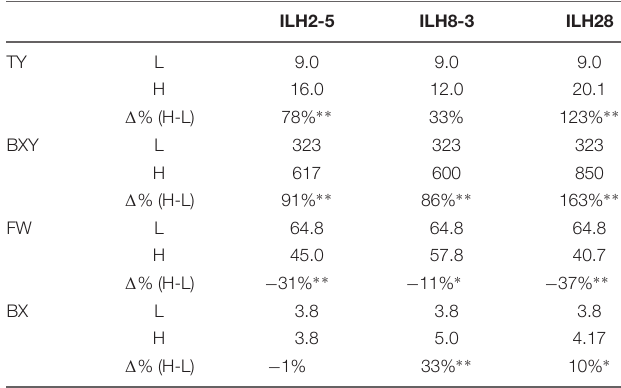
TABLE 1 | Effects of ILH2-5, ILH8-3, and the double ILH28 on yield-related traits.